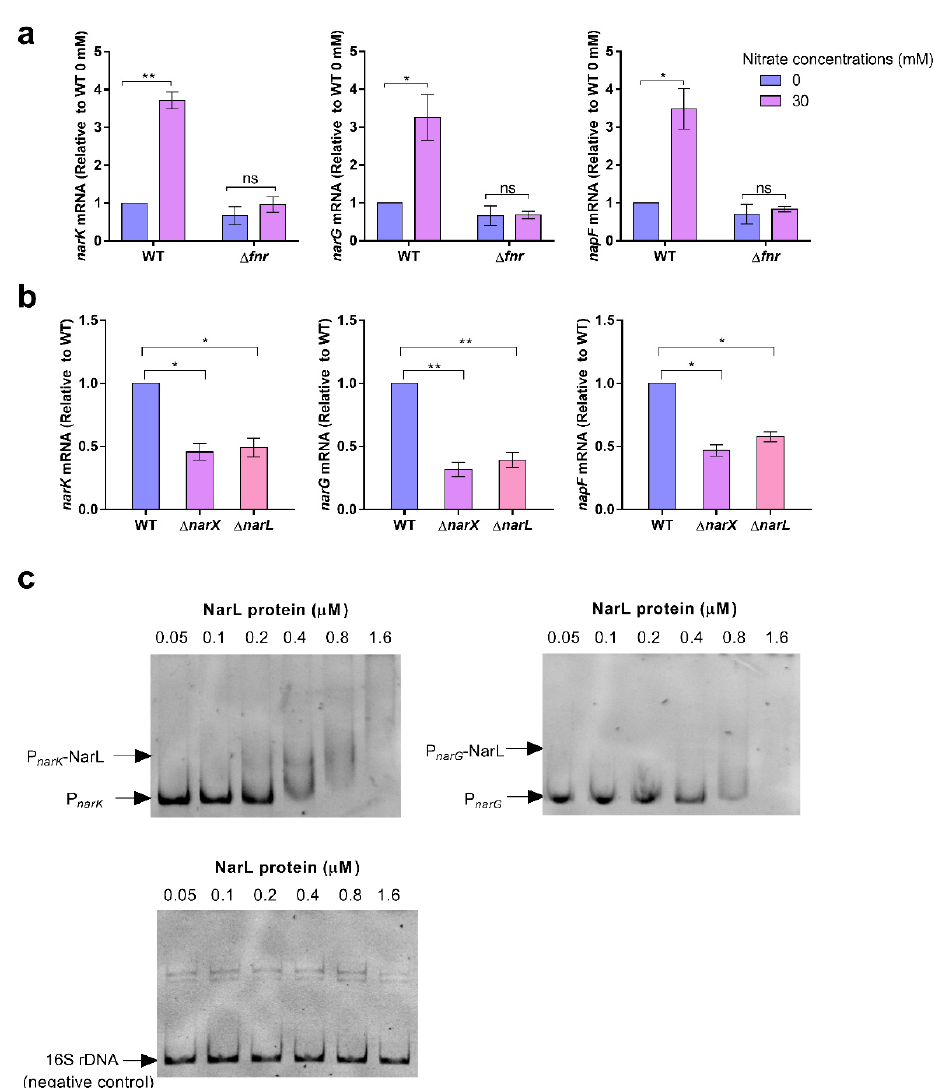
Figure 6. Nitrate utilization is activated by both Fnr and the nitrate-sensing two-component system NarX-NarL under low-oxygen conditions. ( a ) qRT-qPCR analysis of narK , narG , and napF mRNA levels in S. Typhimurium WT and the ∆ fnr mutant. Bacteria were grown in N-minimal medium for 6 h prior to collection. ( b ) qRT-qPCR analysis of narK , narG , and napF mRNA levels in the S. Typhimurium WT, Δ narX mutant, and Δ narL mutant. Bacteria were grown in N-minimal medium for 6 h prior to collection. ( c ) EMSA of the narK and narG promoters with purified NarL protein. The 16S rDNA was used as a negative control. Images are representative of three independent experiments. ( a , b ) Data were generated from three independent experiments and are presented as mean ± SD. p -values were determined using unpaired Student’s t -test (* p < 0.05; ** p < 0.01; ns, not significant).